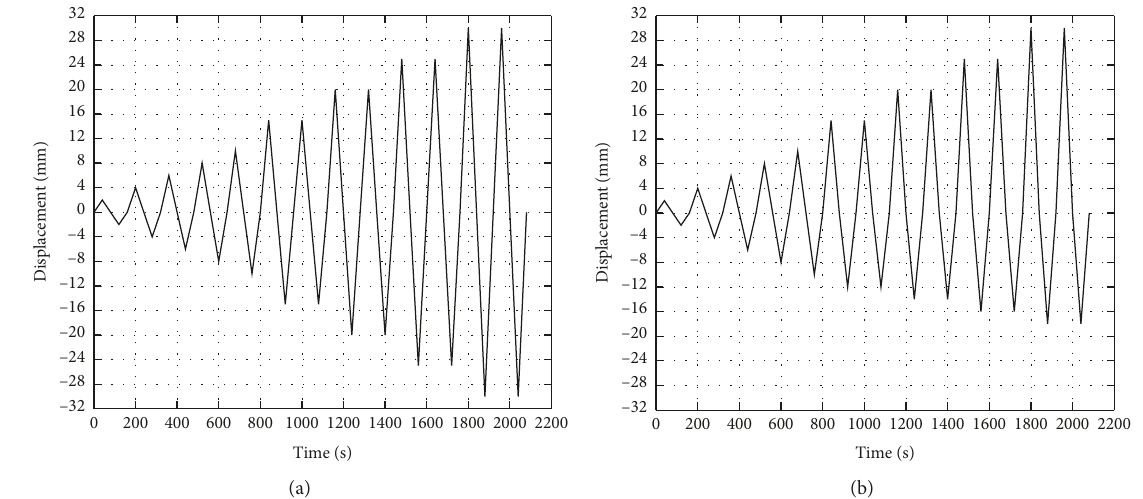
Figure 5: Loading scheme. (a) Loading cycles for PC1. (b) Loading cycles for PC2 and